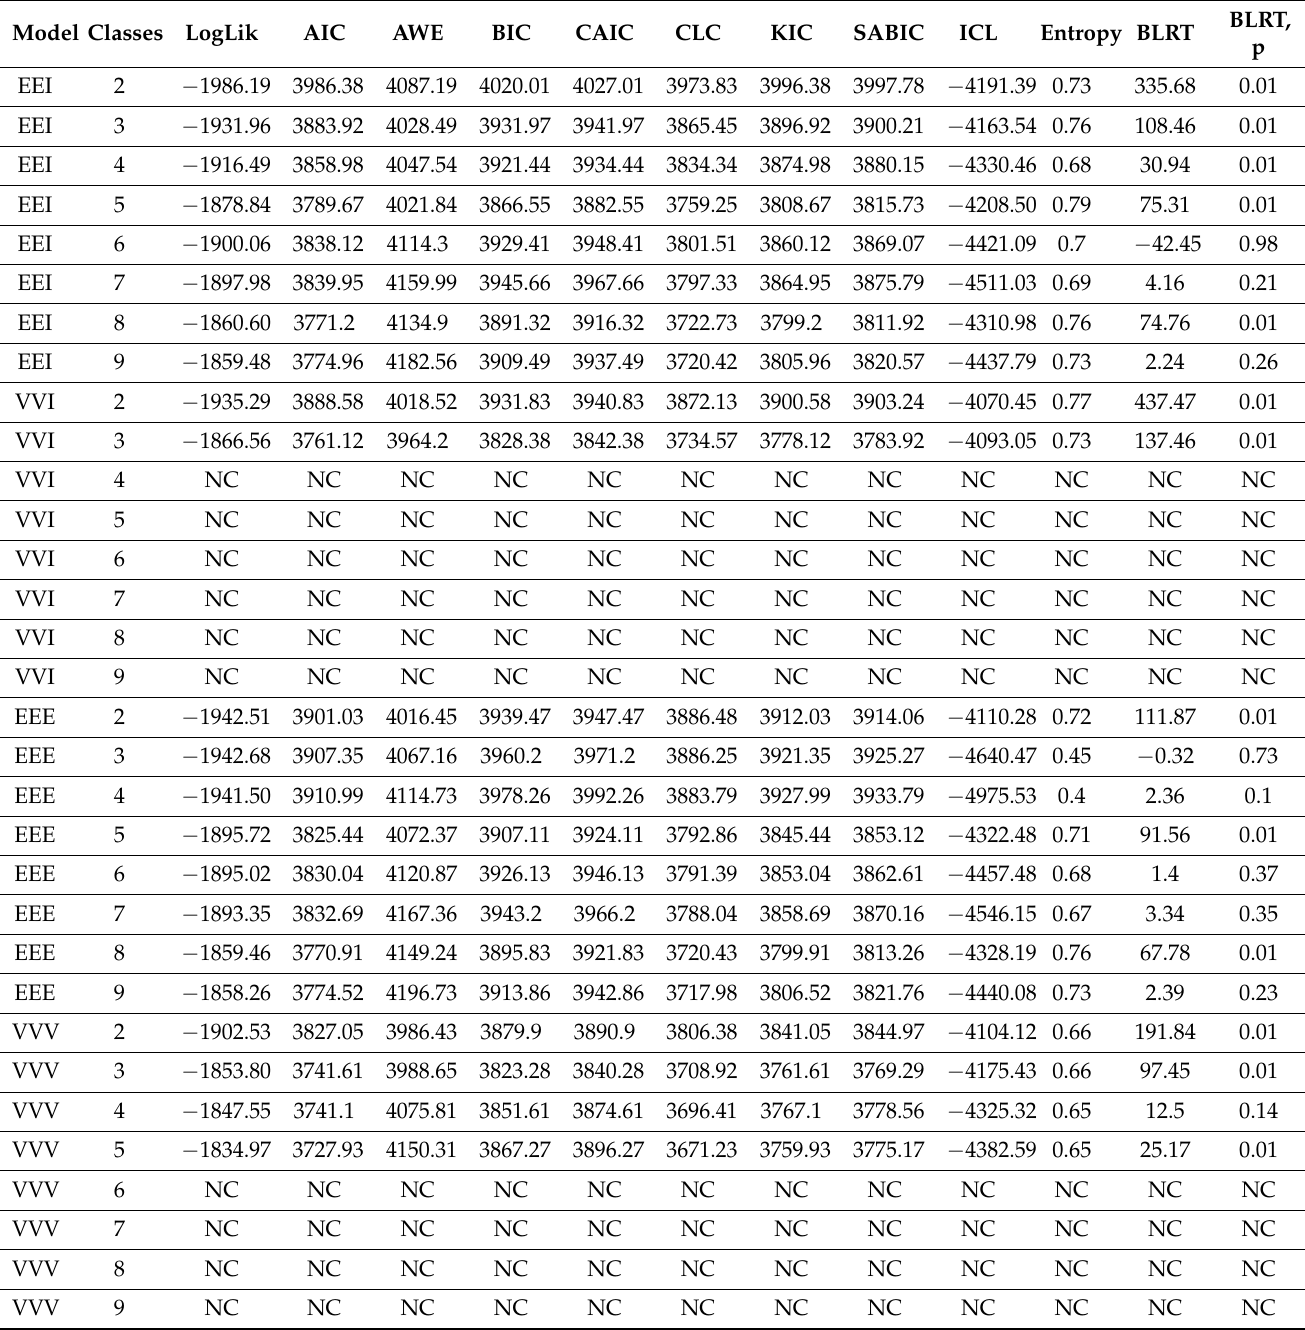
Table 1. Model fit for the latent profile models with different numbers of profiles and different within-profile covariance